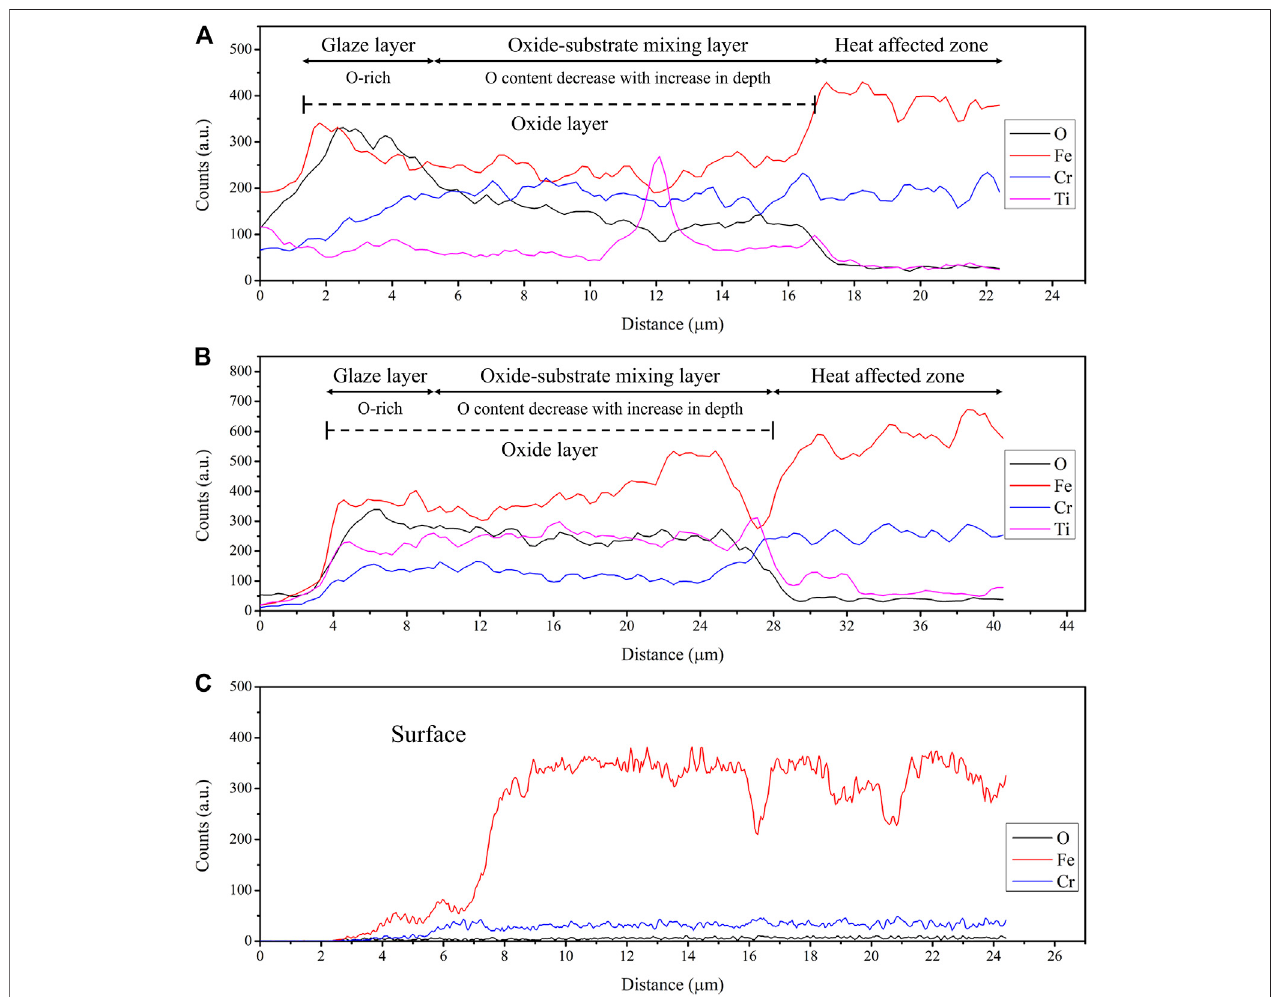
FIGURE9| EDSlinescanof (A) TC02alloy, (B) TC05alloy,and (C) M2steel(Onlypartialelementswhichchangedsigni fi cantlywereselectedtosimplifythe fi gure).